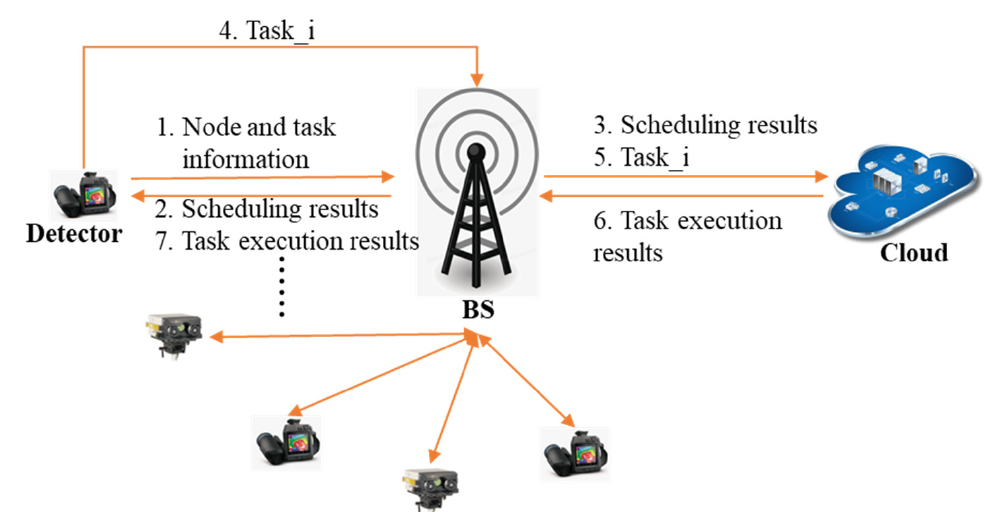
Figure 2. System model.